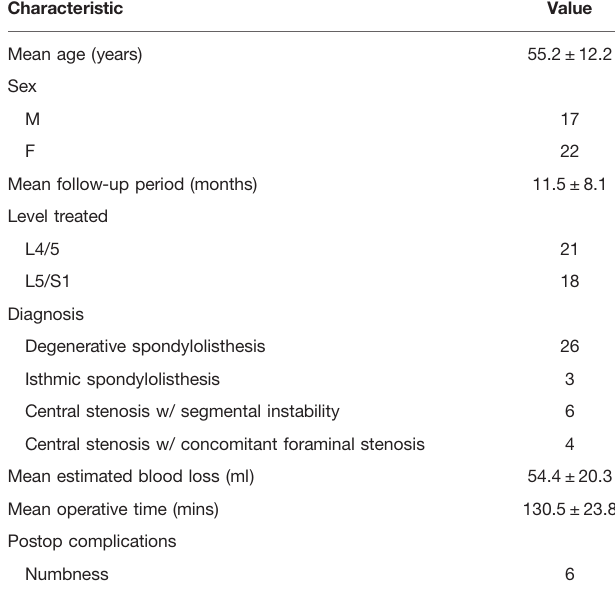
TABLE 2 | Patient